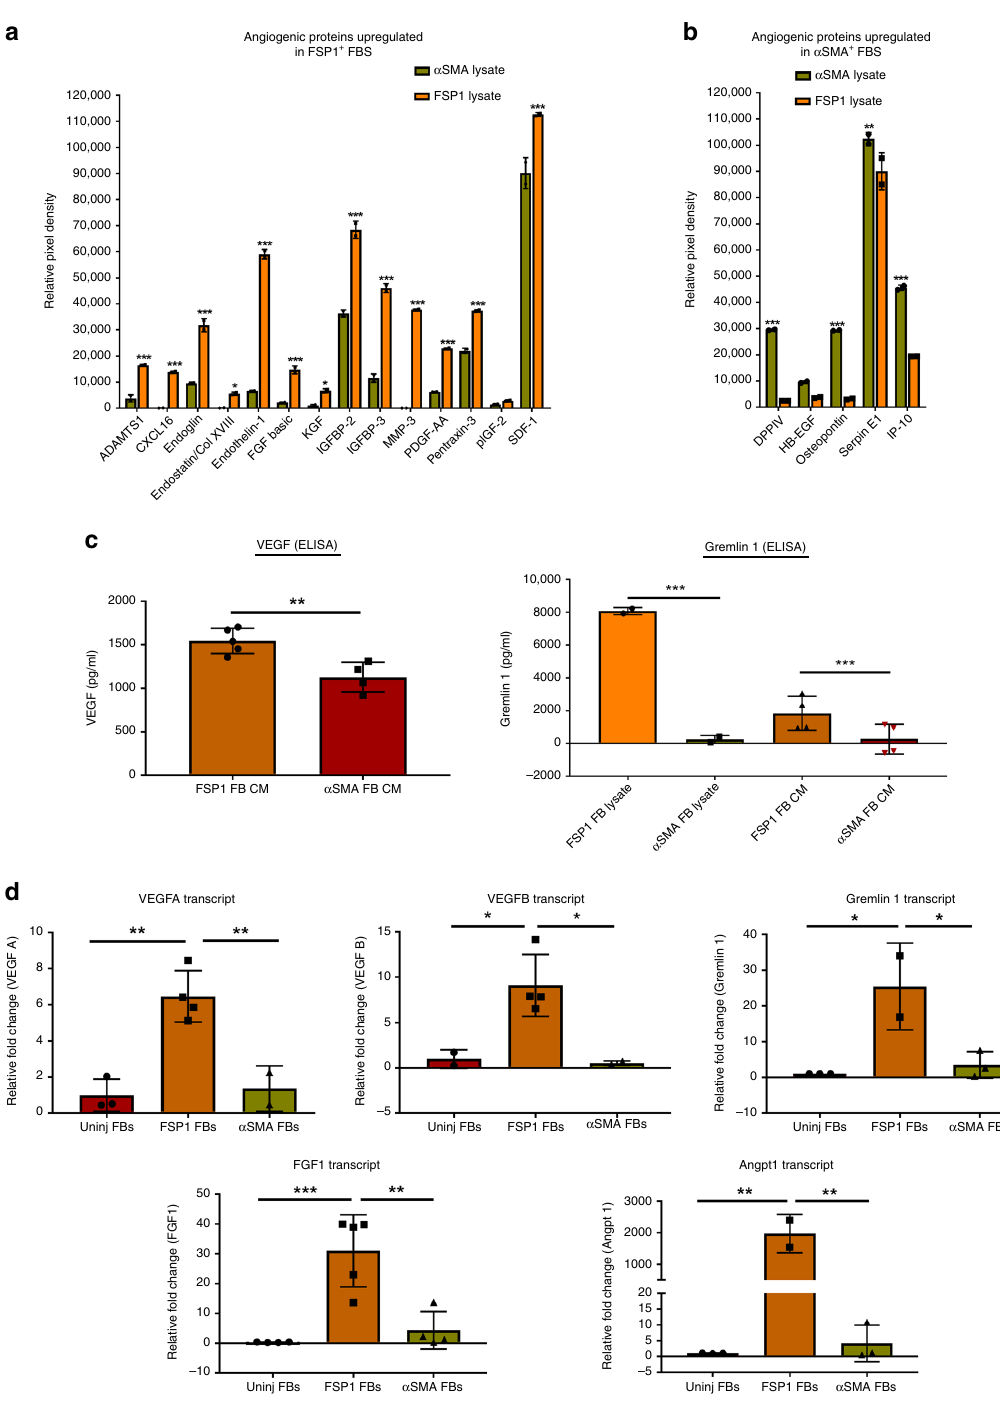
FSP1 + and α SMA + fi broblasts, sorted for implantation, stained negative for endothelial cell markers (VWF and FLK-1), sug- sponges was host derived, and not derived from implanted FSP1